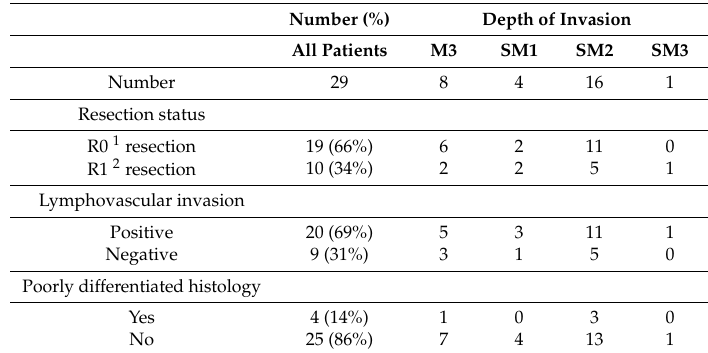
Table 2. The histopathological findings in the ESD group.